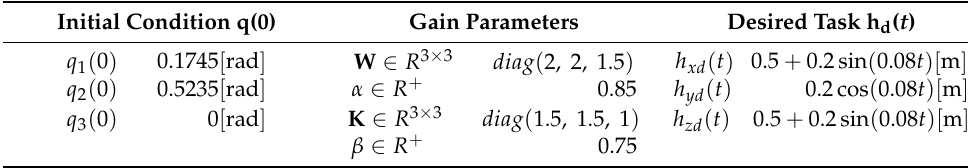
Table 1. Desired task and initial parameters.